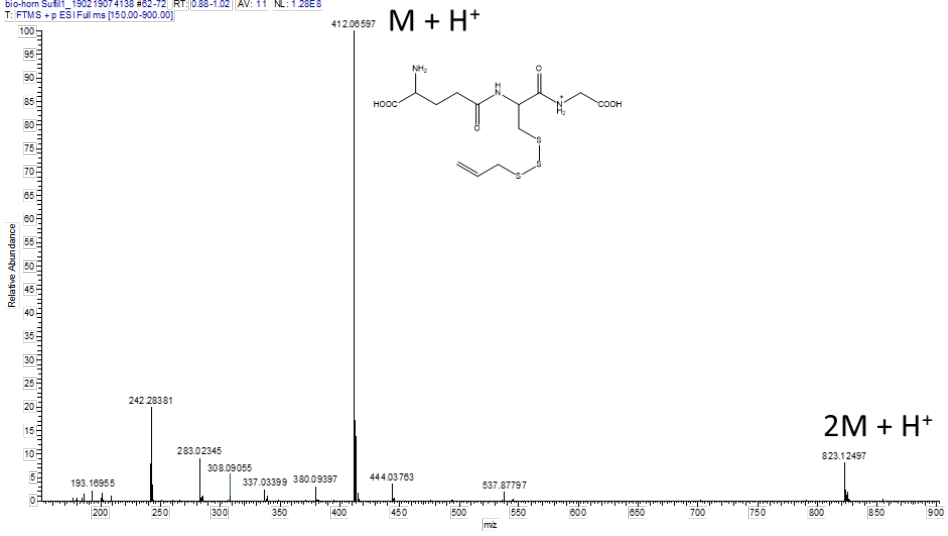
Figure 5. LC/MS of GS 3 A, the putative reaction product of CSA with GSH.